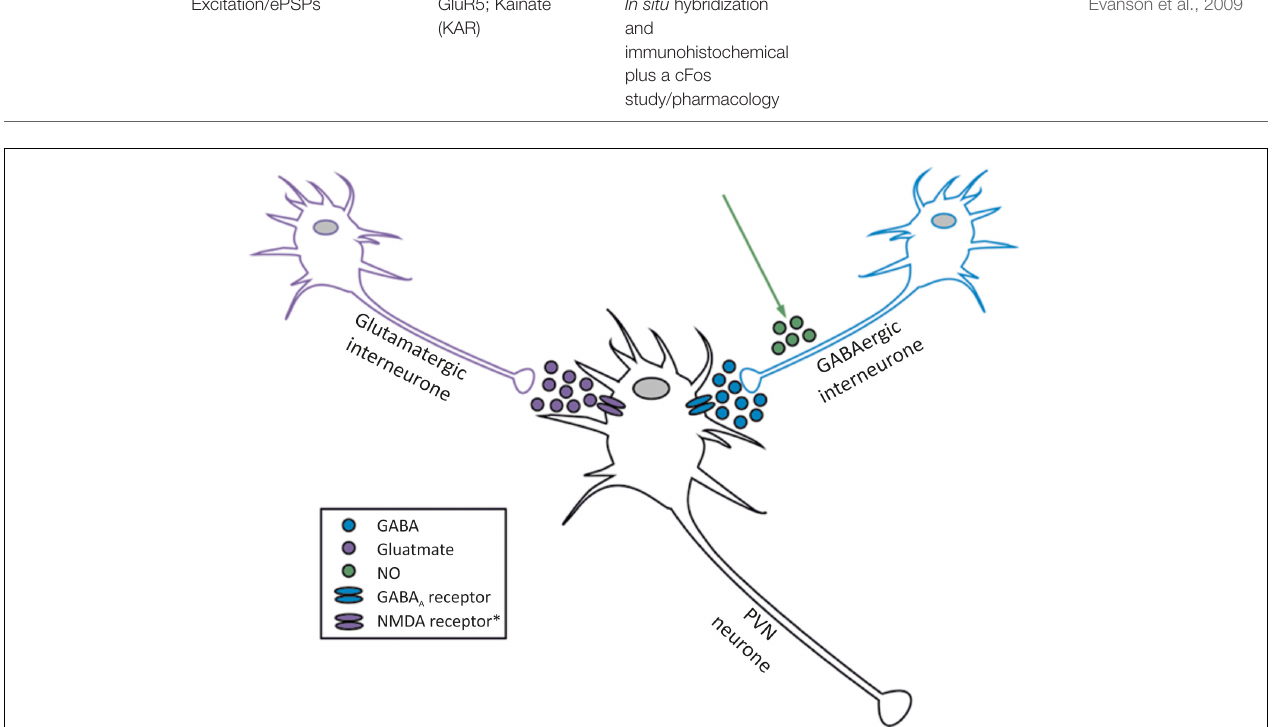
FIGURE 2 | Interaction between glutamate, GABA and NO acting on neurones within the PVN. The two best established inputs to PVN spinally projecting neurones are GABA (inhibitory) and glutamate (excitatory), but NO is one of several factors that amplifies the GABA input. Spinally projecting sympathetic neurones are influenced by NO, but do not produce it themselves (Watkins et al., 2009). ∗ NMDA, kainate and AMPA receptors have been identified in the PVN, please see full text.